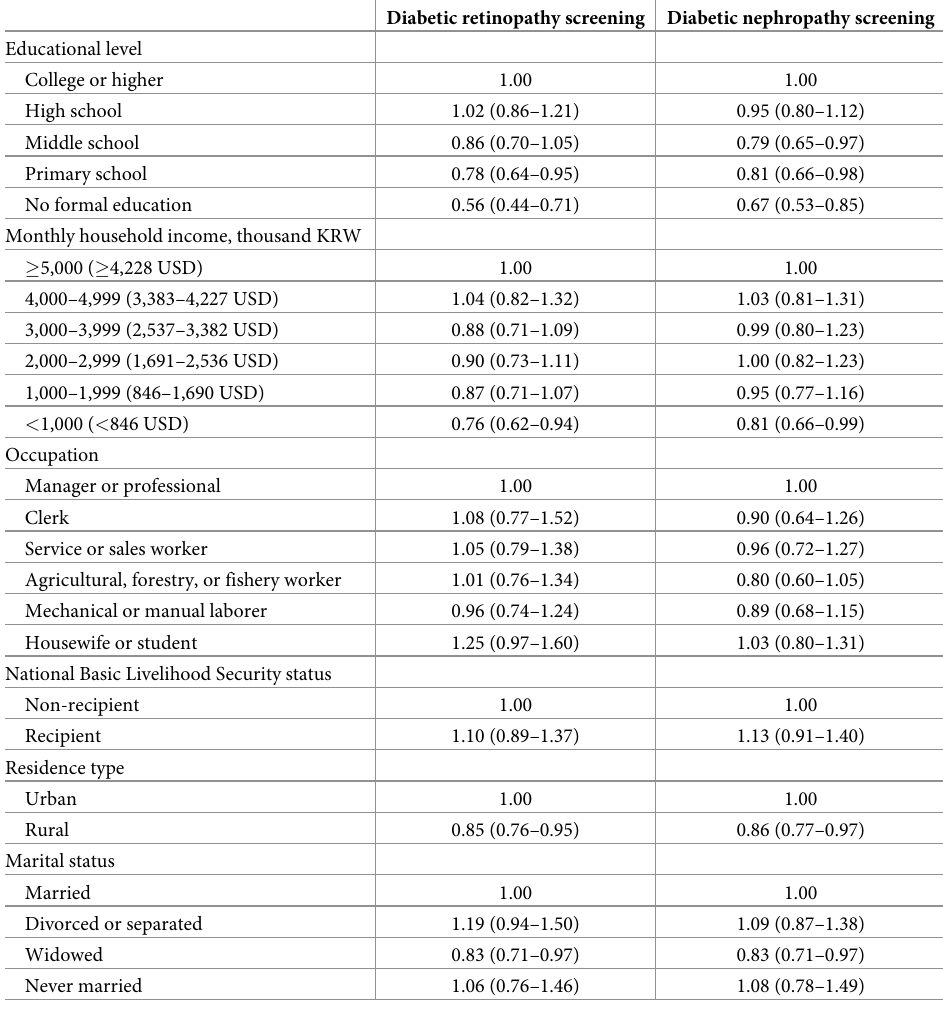
Table 4. Relationships between screening for diabetic retinopathy and nephropathy and socioeconomic status indicators in subjects who reported receiving diabetes education (n = 6,184). Diabetic retinopathy screening Diabetic nephropathy